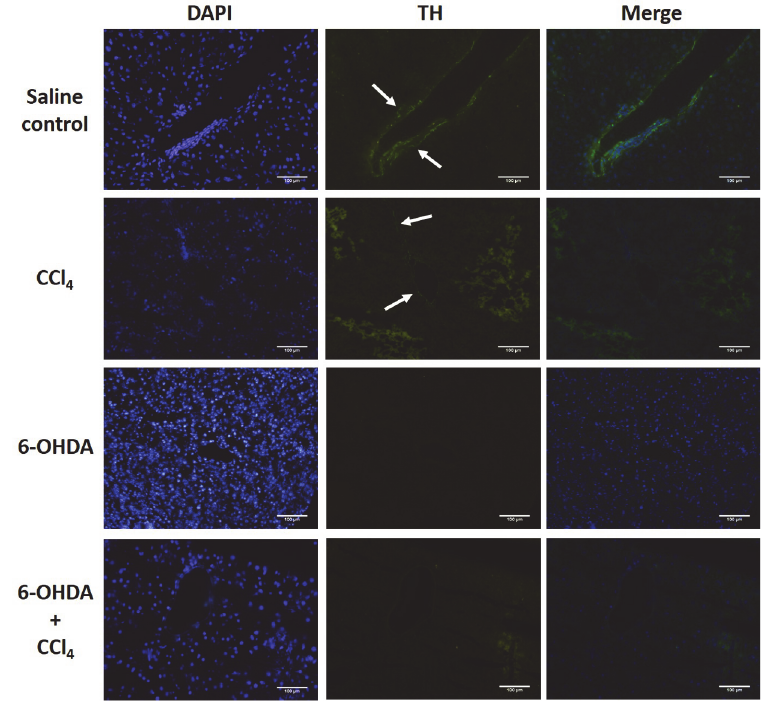
Fig 2. Immunofluorescent analysis of liver tyrosine hydroxylase (TH) reactive nerve fibers. TH positive nerve fibers (arrows) were seen around the portal area in saline treated mice but not in chemical sympathectomised animals. Magnification × 200. The results are representative of four sets of experiments. Scale bar = 100 μ m.